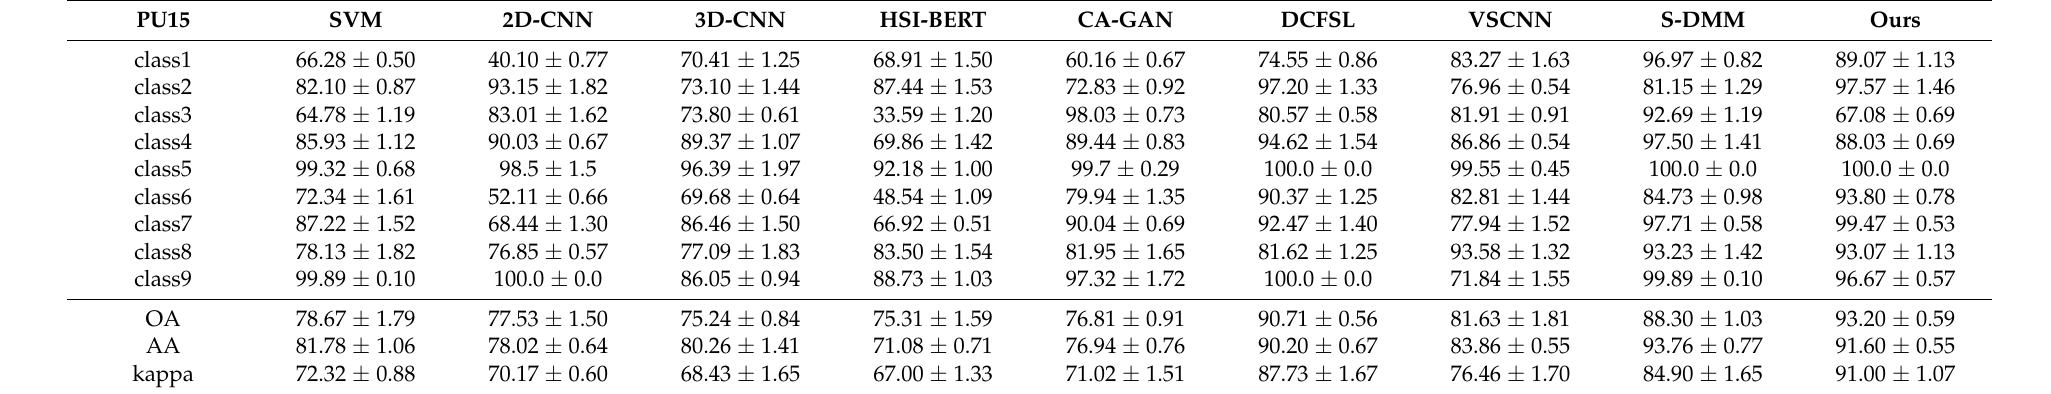
Table 12. The classification results of our proposed and other leading methods on the Pavia University dataset